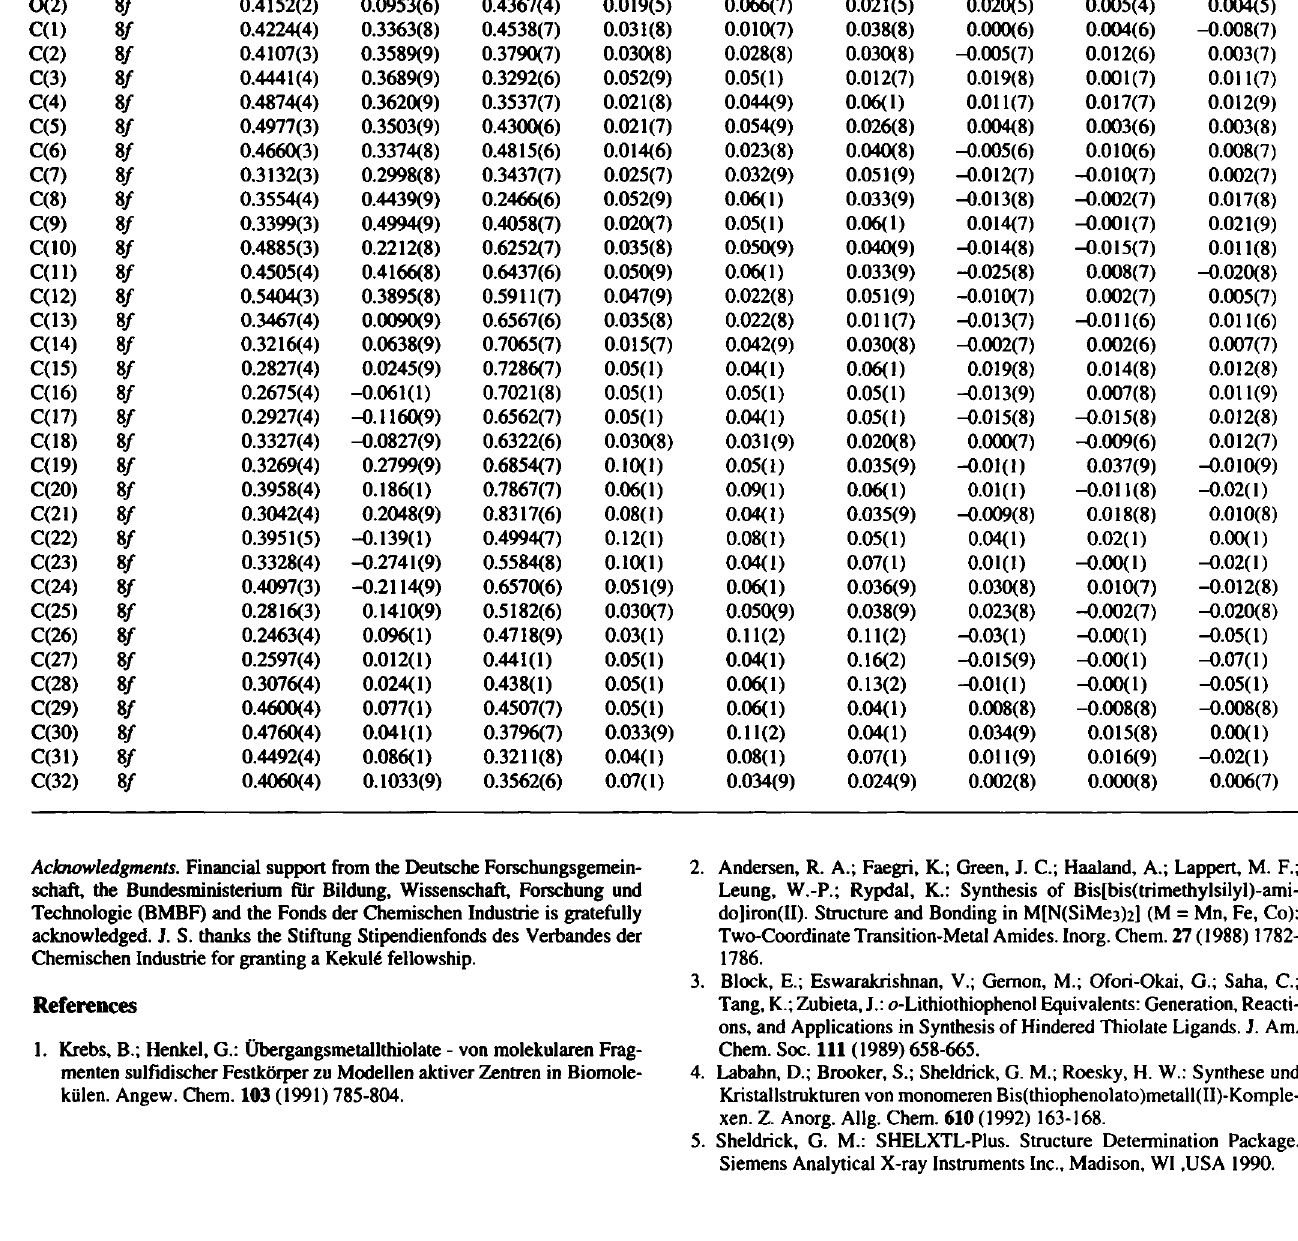
Table 3. Final atomic coordinates and displacement parameters (in